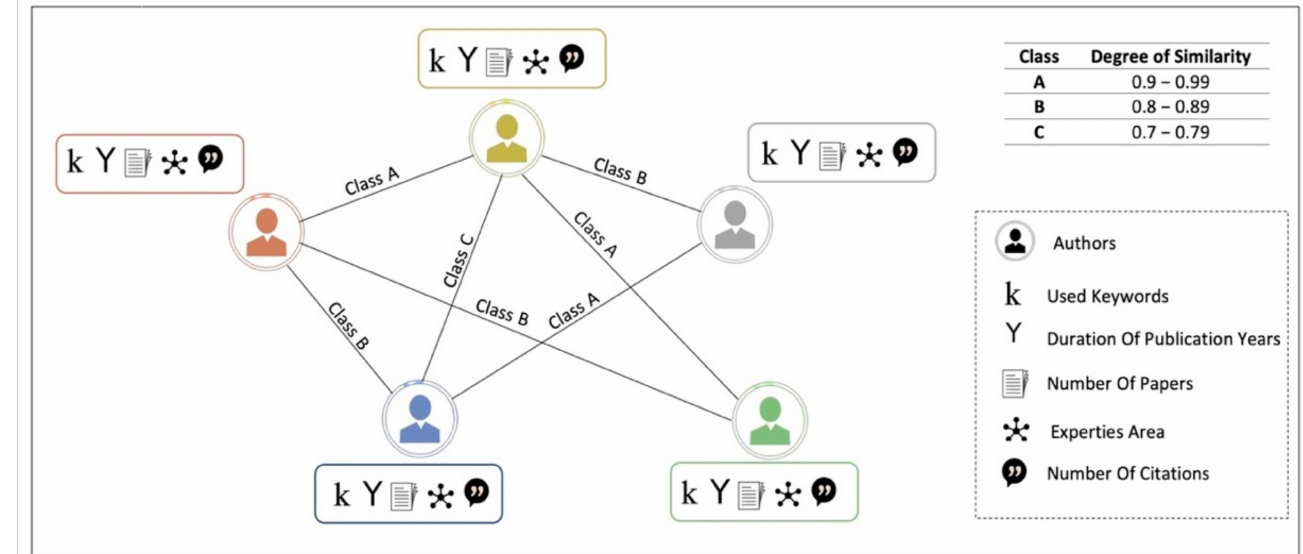
Figure 2. Conceptual view of the proposed